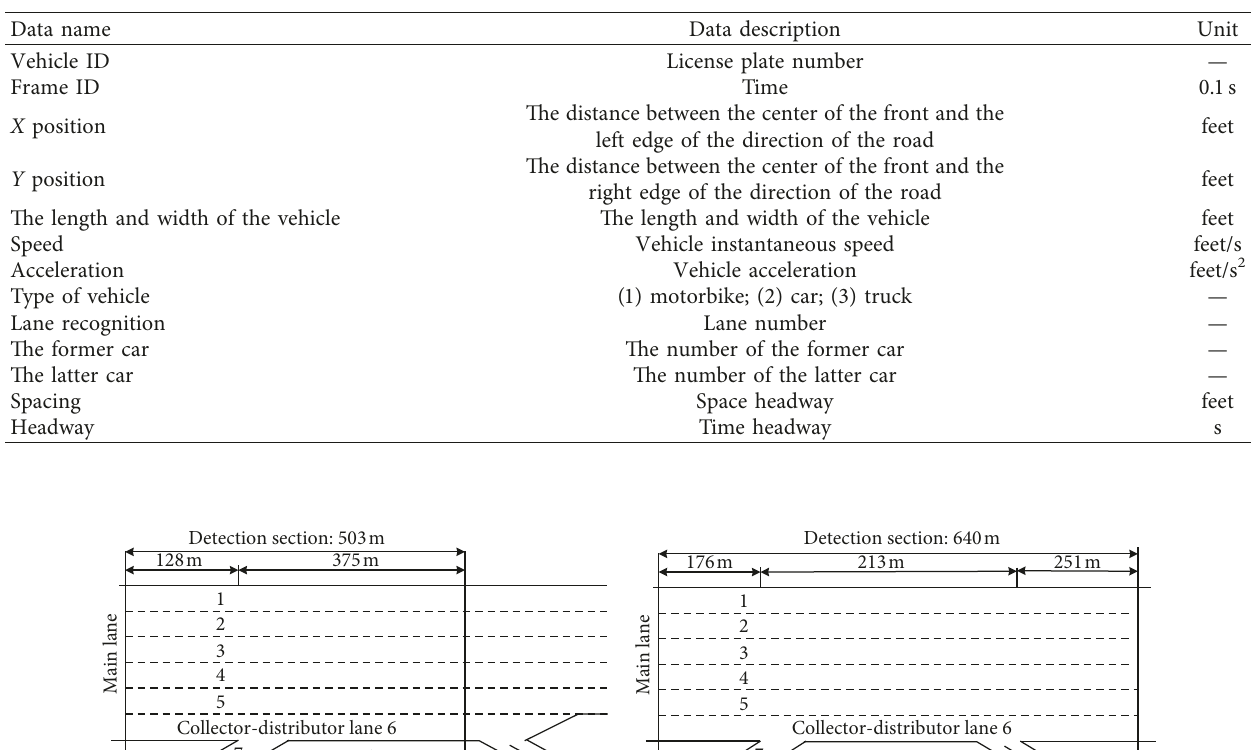
Table 1: NGSIM data attribute.